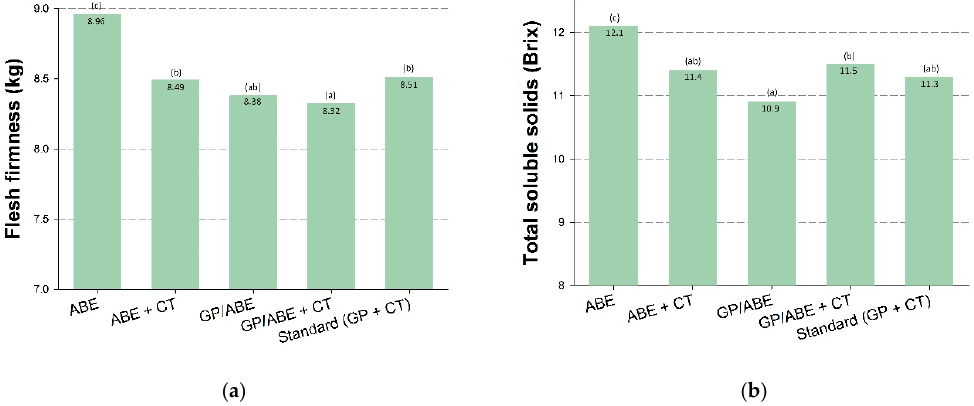
Figure 6. Effect of artificial bud extinction (ABE), pruning level and chemical thinning (CT) on ( a ) fruit flesh firmness and ( b ) total soluble solids content of ‘Buckeye Gala’. Letters above bars indicate mean separation at p =